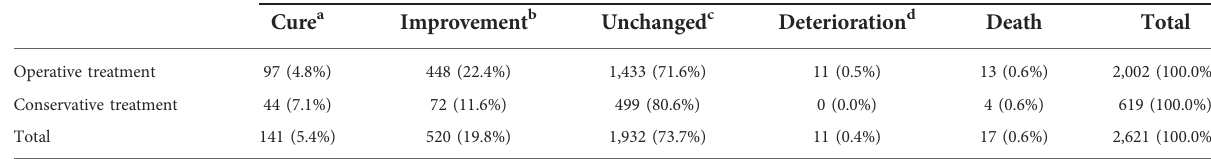
TABLE 4 Treatment of TSCI and functional changes in discharge and admission. Treatment of TSCI